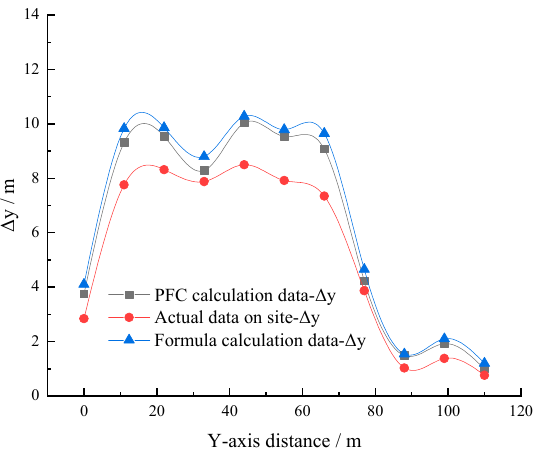
Figure 12. Calculated, simulation, and real data depth comparison